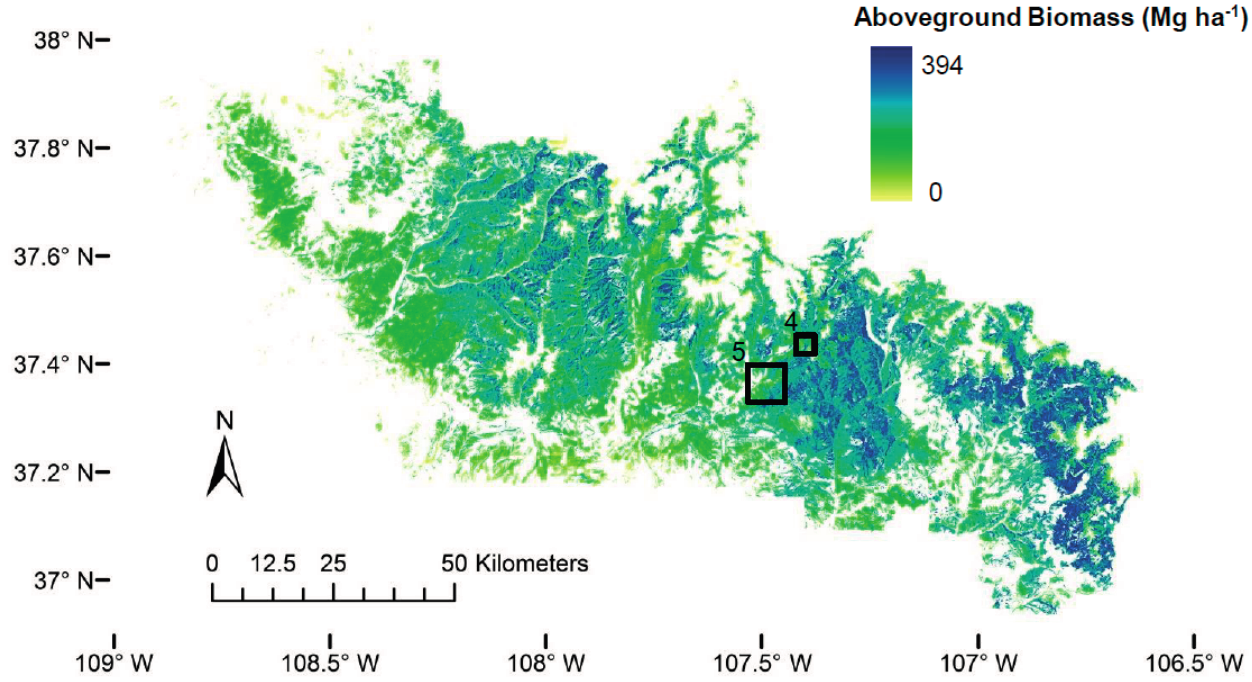
Figure 3. Landsat TM image texture-based map of aboveground biomass within forested regions of San Juan National Forest. The boxes labeled 4 and 5 indicate the location of Figures 4 and 5,